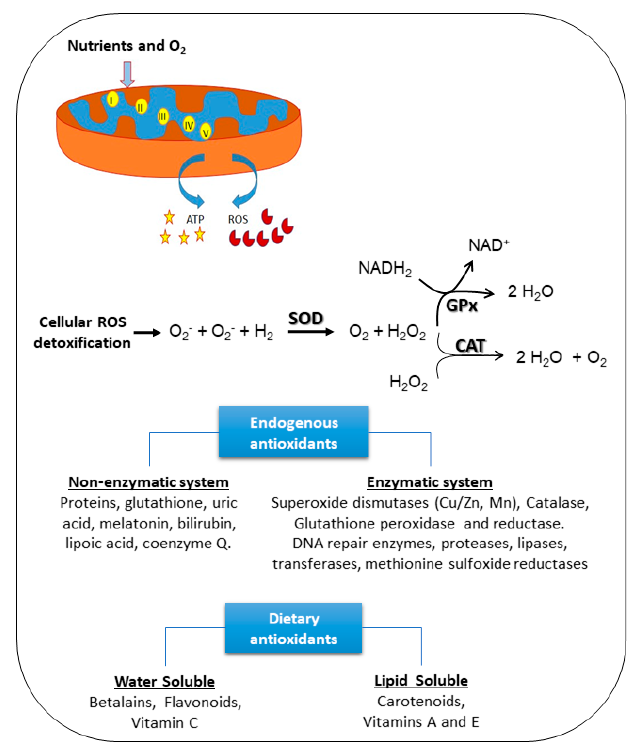
Figure 4. Cellular antioxidant defense systems. ROS, reactive oxygen species; SOD, superoxide dismutase.